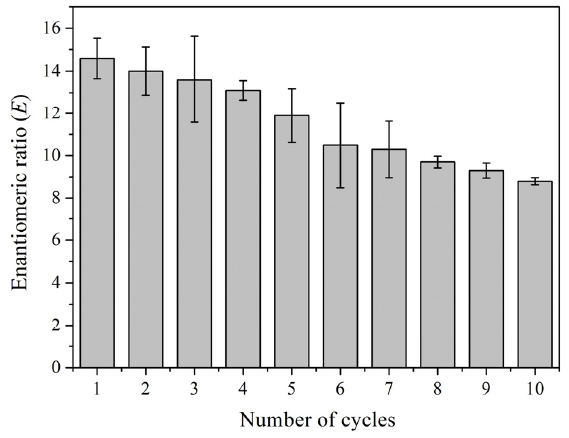
Figure 9. Typical GC chromatogram of the sample after immobilized enzyme ‐ catalyzed kinetic resolution of ( R , S ) ‐ 2 ‐ octanol with vinyl acetate as an acyl donor. The peaks at retention times of 45.622, 45.777, 46.844, and 49.734 min represented R ‐ 2 ‐ octanol, S ‐ 2 ‐ octanol, produced S ‐ 2 ‐ octanol ester, and R ‐ 2 ‐ octanol ester, respectively.